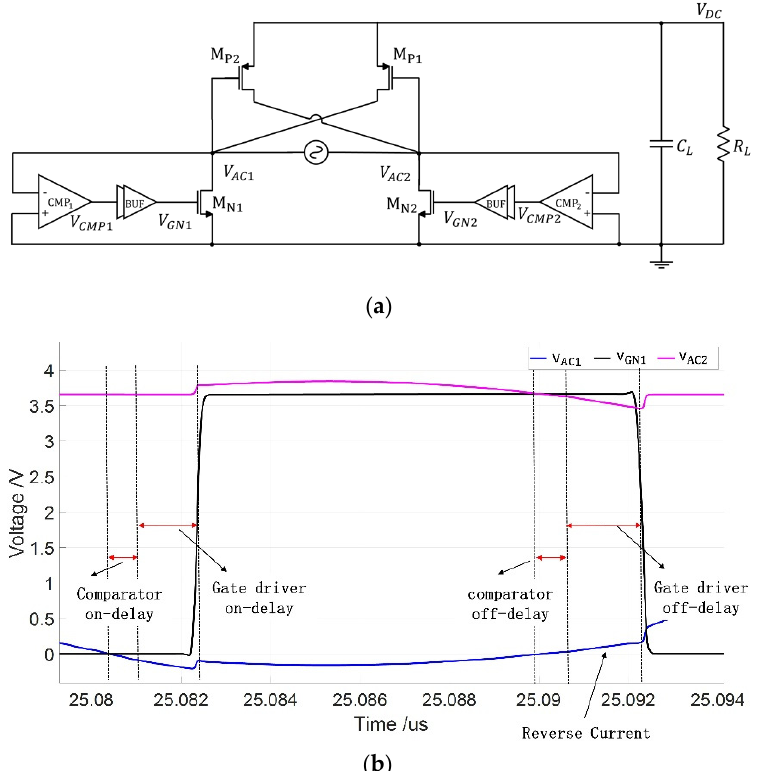
Figure 2. ( a ) The schematic and ( b ) the waveforms with various delays of the widely used active